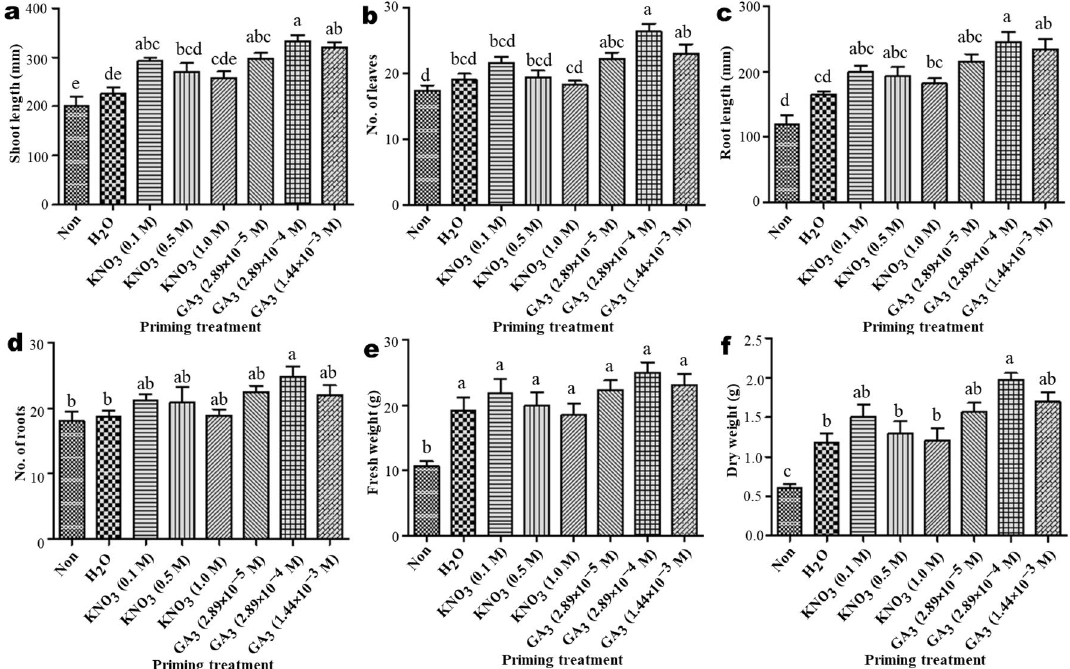
Figure 5. Effect of priming treatment on early growth of A. africana. Growth parameters measured after three months of growth. ( a ) Shoot length ( b ) Number of leaves ( c ) Root length ( d ) Number of roots ( e ) Fresh weight ( f ) Dry weight. Values are presented as means ± standard error. Same letters are not significantly different by Bonferroni’s test and p =